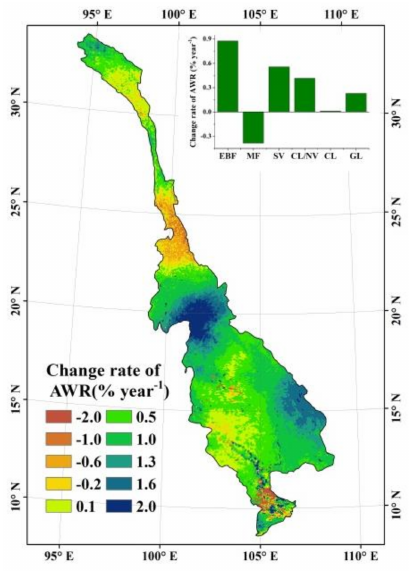
Figure 5. Spatial patterns of the temporal variation of annual average available water resources (AWR) for the period of 1981 to